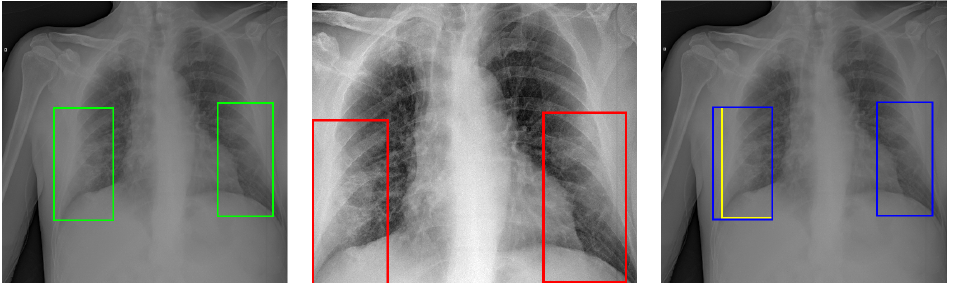
Figure 7. Bounding boxes before and after the cropping procedure of the images. ( Left ): Origi- nal image with its original bounding boxes (green line). ( Centre ): Cropped image with resized bounding boxes (red line). The left original bounding box falls partly outside the area cropped. As a result, its size is resized. ( Right ): Comparison of the original (blue line) and resized (yellow line) bounding